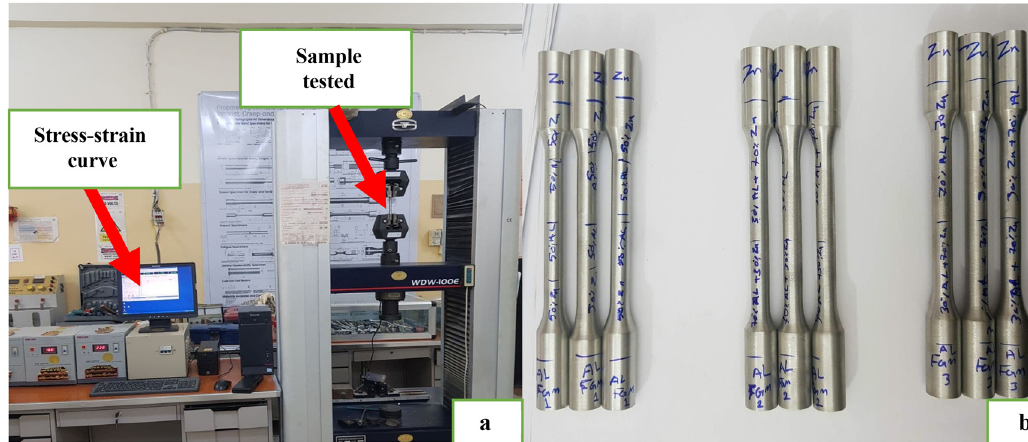
Figure 8: ( a ) Tensile machine and ( b ) samples tested.